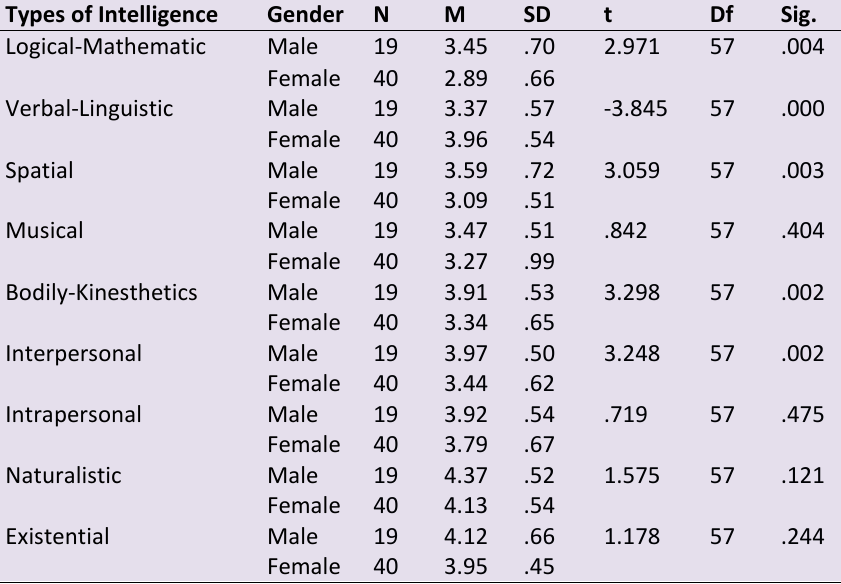
Table 4. Result of Independent t Test for Gender and Multiple Intelligences Types of